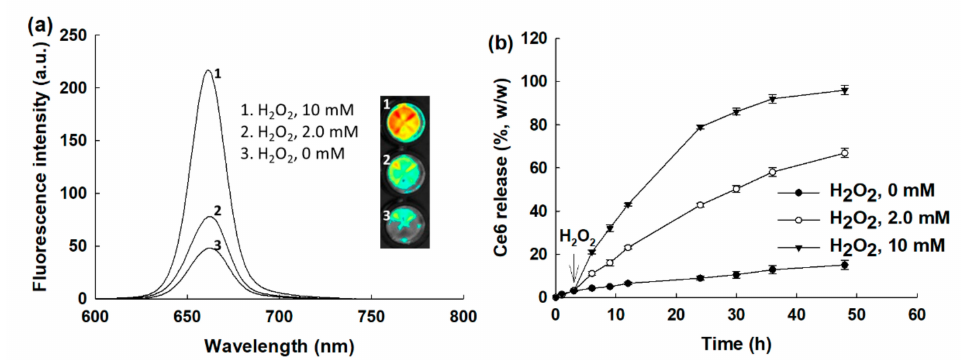
Figure 4. The effect of H 2 O 2 concentration on the changes in the fluorescence emission spectra ( a ) and drug release ( b ). To measure fluorescence emission spectra, nanophotosensitizers in PBS (0.1 mg/mL) were incubated in the presence of H 2 O 2 at 37 ◦ C for 3